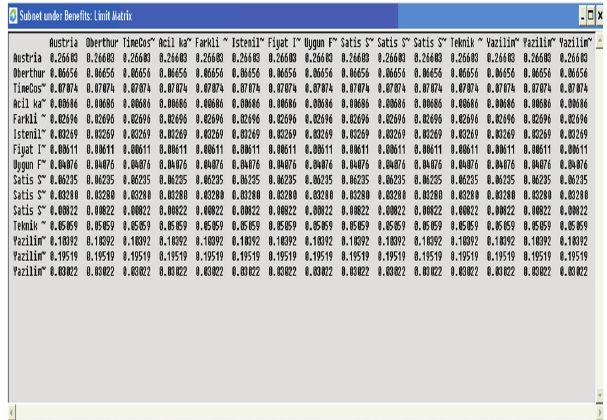
Figure 10: Limit